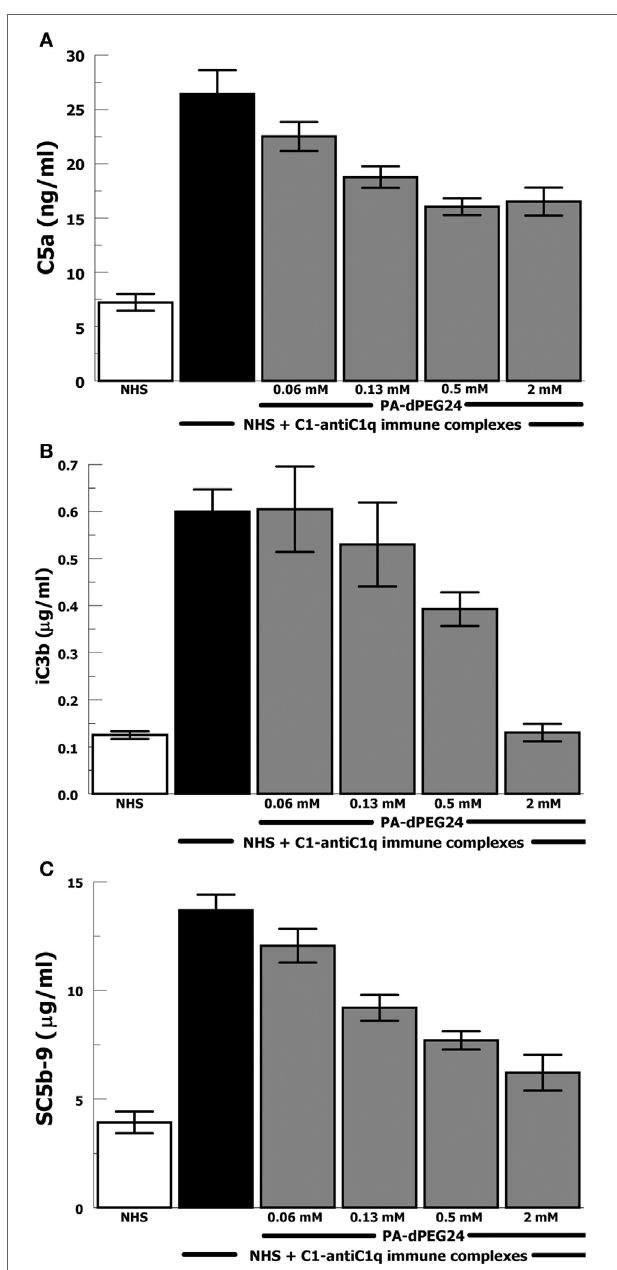
FigUre 3 | PA-dPEG24 inhibition of C1-anti-C1q immune complex-initated complement activation assayed by complement effectors. (a) PA-dPEG24 inhibition of C5a generation in normal human sera (NHS) stimulated with C1-anti-C1q immune complexes (IC). Data are means of ( n = 4) independent experiments ± SEM. (B) PA-dPEG24 inhibition of iC3b generation in NHS stimulated with C1-anti-C1q IC. Data are means of ( n = 4) independent experiments ± SEM. (c) PA-dPEG24 inhibition of SC5b-9 generation in NHS stimulated with C1-anti-C1q IC. Data are means of ( n = 4) independent experiments ±